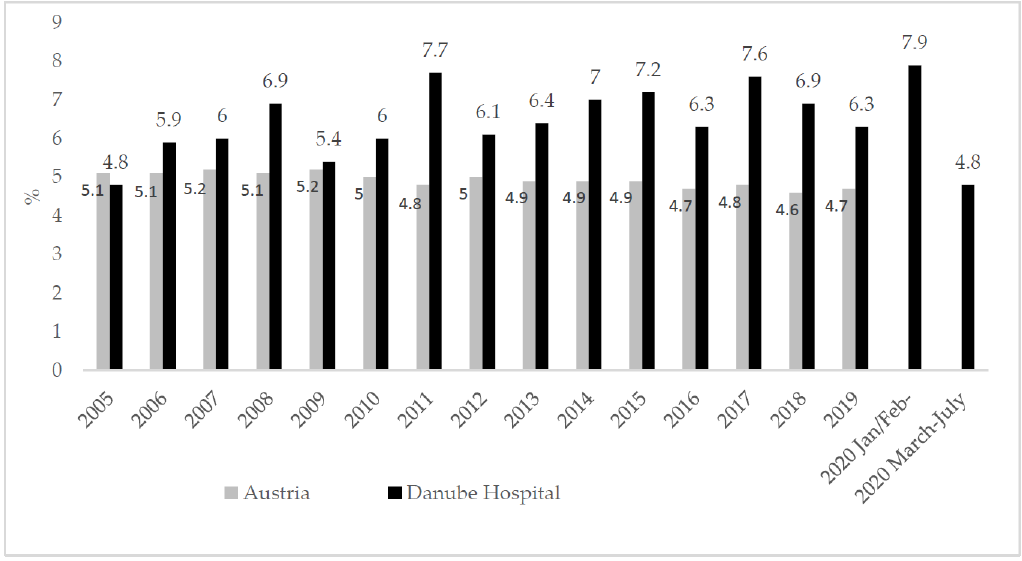
Figure 1. Prevalence of birth weight below 2500 g in Austria (data source: [42]) and in the Danube Hospital 2005 to 2020. Comparing the rate/1000 LBW between the pre-lockdown months of January/February 2020 and the lockdown months of March to July 2020 showed a significantly higher rate ( p = 0.049) of LBW in January/February (54.2/1000) than during the lockdown period of March to July (38.9/1000). The risk of giving birth to a LBW newborn was significantly higher during pre-lockdown period (OR 1.66 CI 0.98–2.81). The rates of extremely low birthweight (<1000 g), very low birthweight (1000–1500 g) and low birthweight (1501– 2500 g) at the Danube hospital are listed in Table 1. The comparison of the pre-lockdown months of January/February 2020 and the lockdown months of March to July 2020, yielded markedly higher risks of ELBW (OR 2.48 CI 0.35–17.50), VLBW (OR 2.05 CI 0.63–6.67) and LBW (OR 1.41 CI 0.76–2.62) during the pre-lockdown months. The rates of low, very low and extremely low birthweight between January and July 2020 are listed in Table